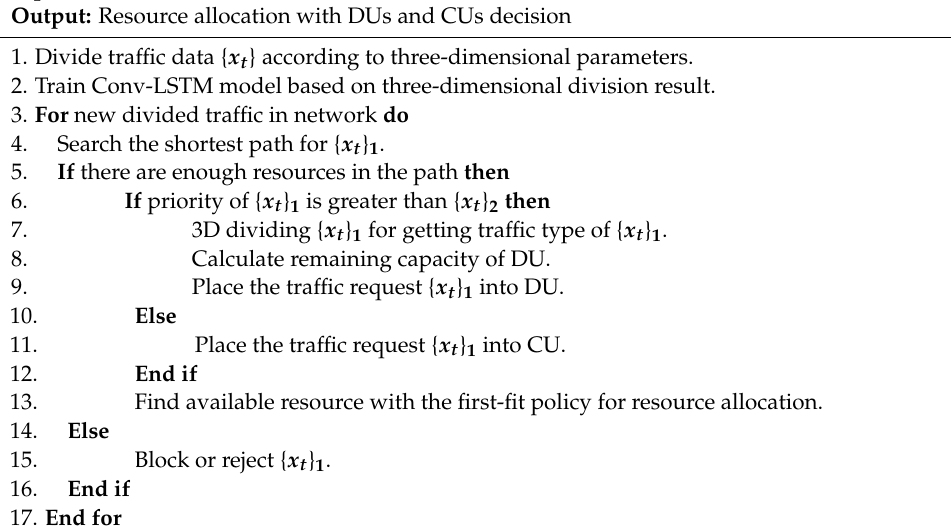
Algorithm 1: Priority-based TDTS Algorithm.